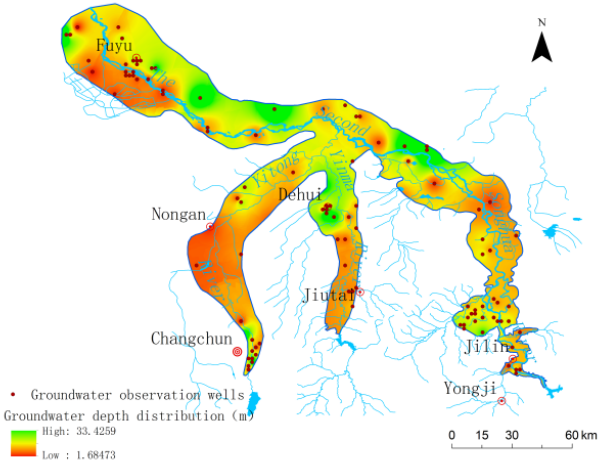
Figure 20. Groundwater depth distribution.